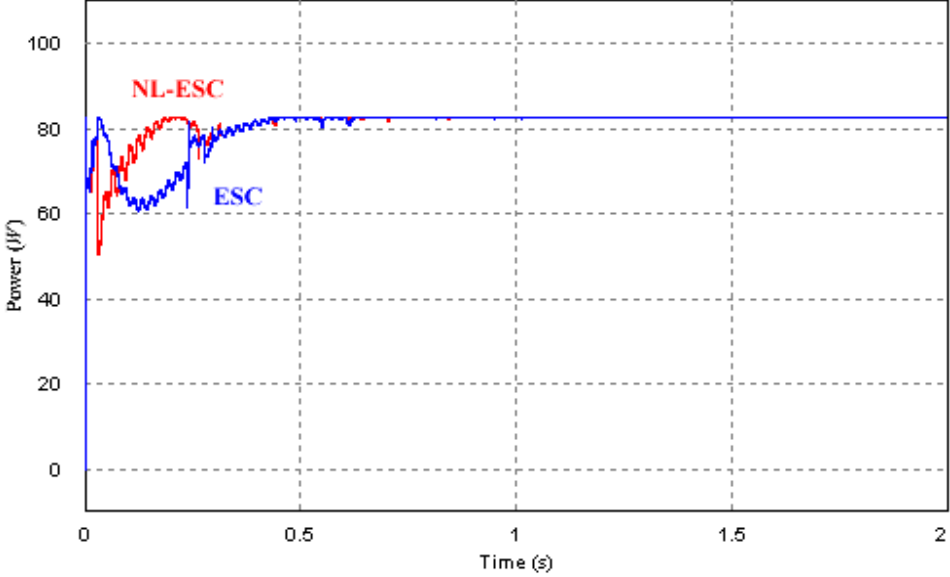
Figure 12. Transient of panel power from D Transient of panel power from D